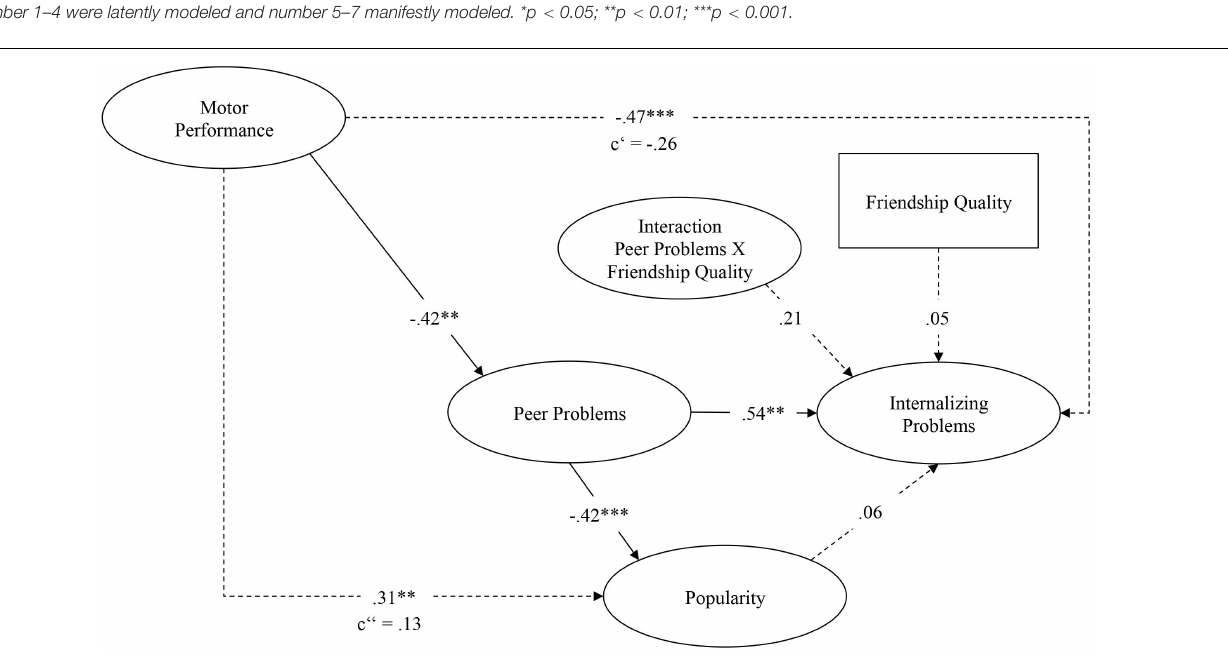
( β = − 0.42, p < 0.01) and